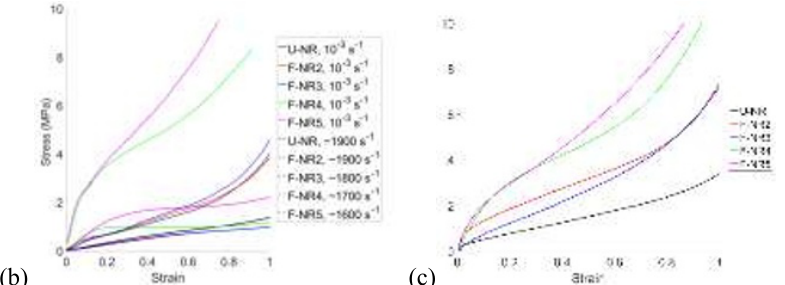
Figure 2. (a) Master curve for each material generated at a reference temperature of 25 °C. (b) Highlighting selected varying strain rate experiments at 25 °C and (c) low temperature experiments at -40 °C and 10 -2 s -1